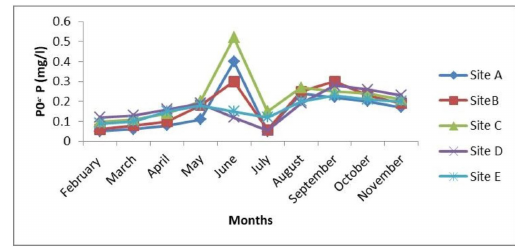
Figure 7. Monthly mean variations in nitrate-nitrogen of Nasarawa Reservoir.